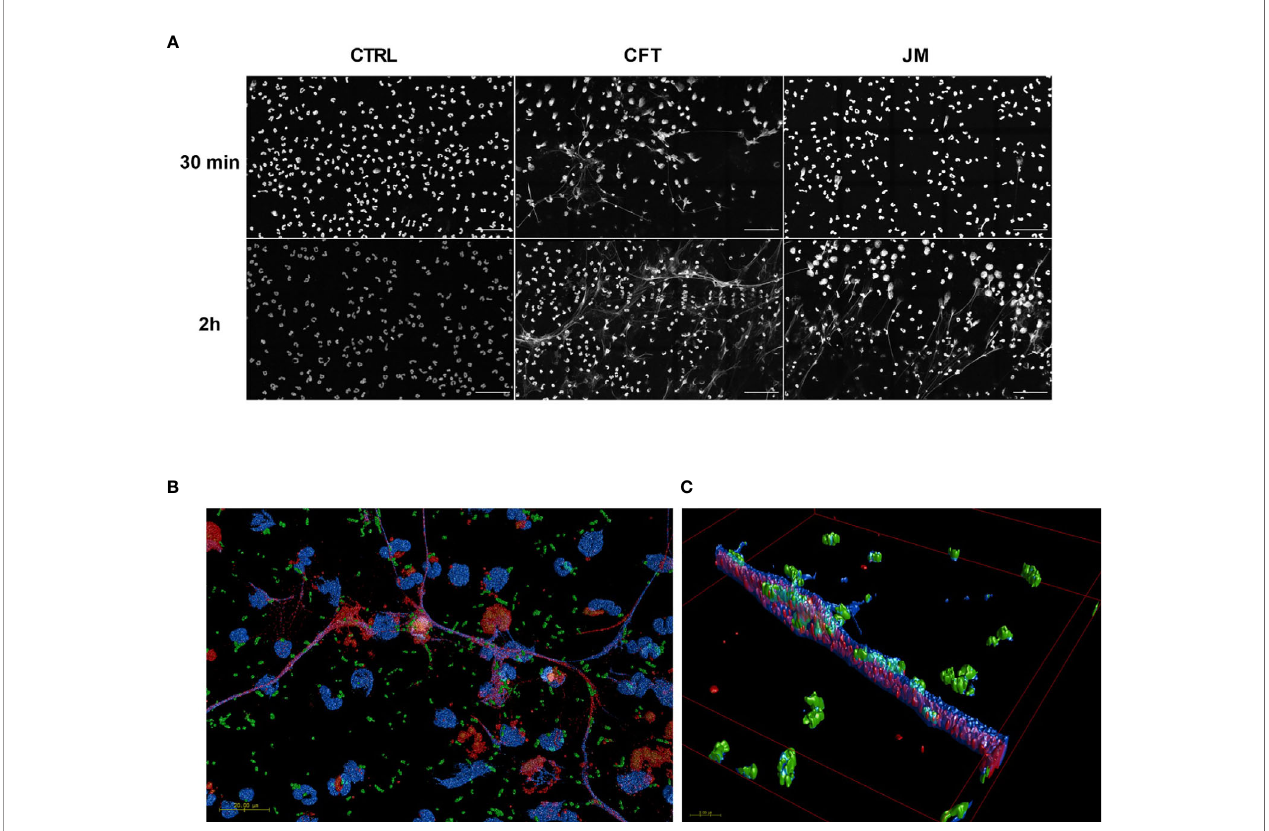
FIGURE 4 | Coculture conditions induce NETosis. 2x10 6 /ml of neutrophils were seeded on coverslips and co-incubated with 20x10 6 /ml CFT073 or JM109 or without bacteria for the indicated time durations at 37°C. Following incubation cells were fi xed, permeabilized and stained with immuno fl uorescence for DNA with DAPI (blue), MPO (red) and E. coli (green) as mentioned in materials and methods. (A) Large fi eld representation with 15 panels in gray scale using blue channel to show the extent of the NET formation. Scale bar is 50µm. (B) 3D representations of confocal data of fi fteen 100x tiles of CFT073 cocultures at 30 min. Scale bar 20 µm. (C) A zoomed in area on a net (B) . The overlap between DAPI (which is made slightly transparent to visualize internal co-localization) and bacteria are seen as a teal color. Overlap between MPO and DAPI appears